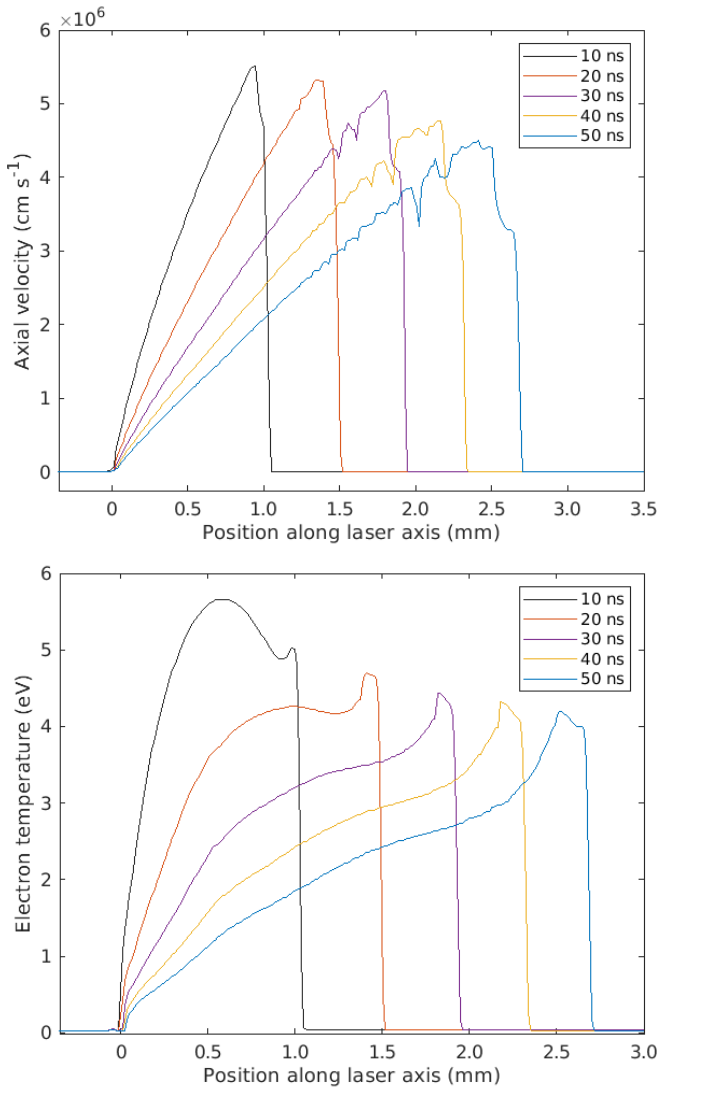
Figure 3. Spatial distribution of the simulated axial velocity ( top ) and electron temperature ( bottom ) profiles of a titanium plasma plume for different times after the start of the 16 ns laser pulse. The laser fluence was 100.5 J cm − 2 and the laser focus was 100 µ